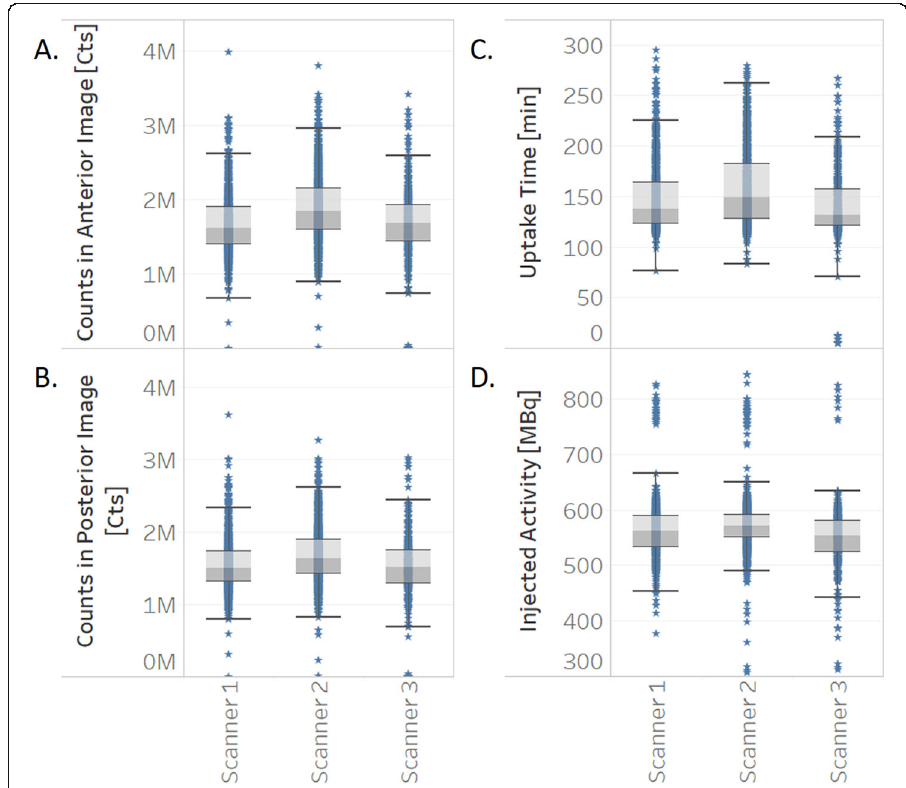
Fig. 6 Comparison of three AnyScan SPECT systems from the aspects of total counts of anterior and posterior images acquired ( a , b ), injected activity ( d ), and uptake time ( c ) related to 99m Tc-MDP bone